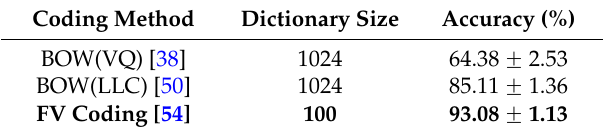
Table 2. The results obtained using three different coding methods on local